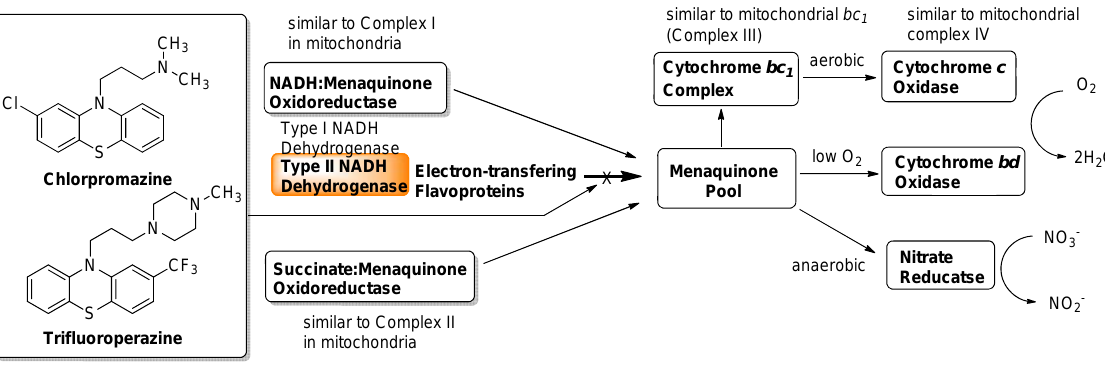
Figure 6. Electron flow in M. tuberculosis and type II NADH dehydrogenase